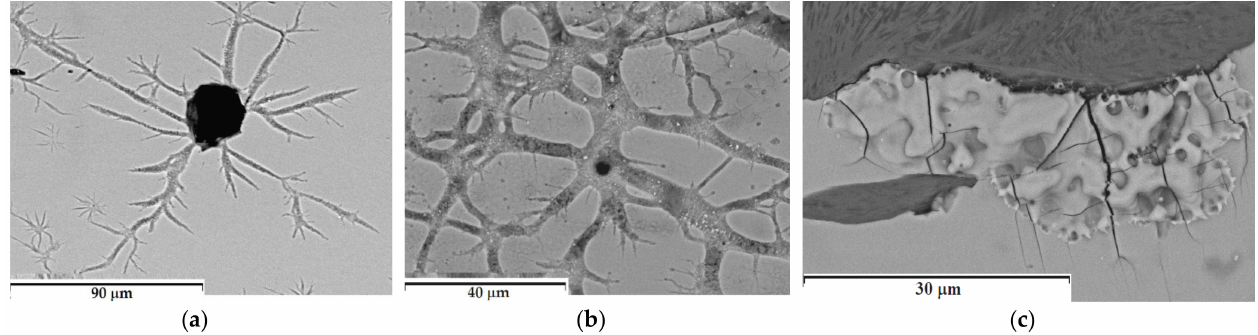
Figure 3. Damaged pyrite surface as a result of exposure to HPEMP. SEM; scale bars: ( a ) 90 µ m, ( b ) 40 µ m, and ( c ) 30 µ